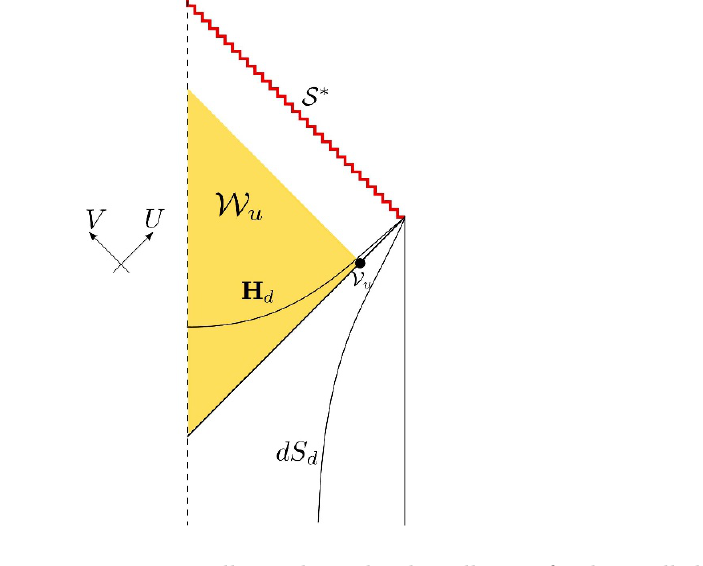
Figure 13 . The idealized state generating a null singularity by the collision of a thin-walled bubble with dS d